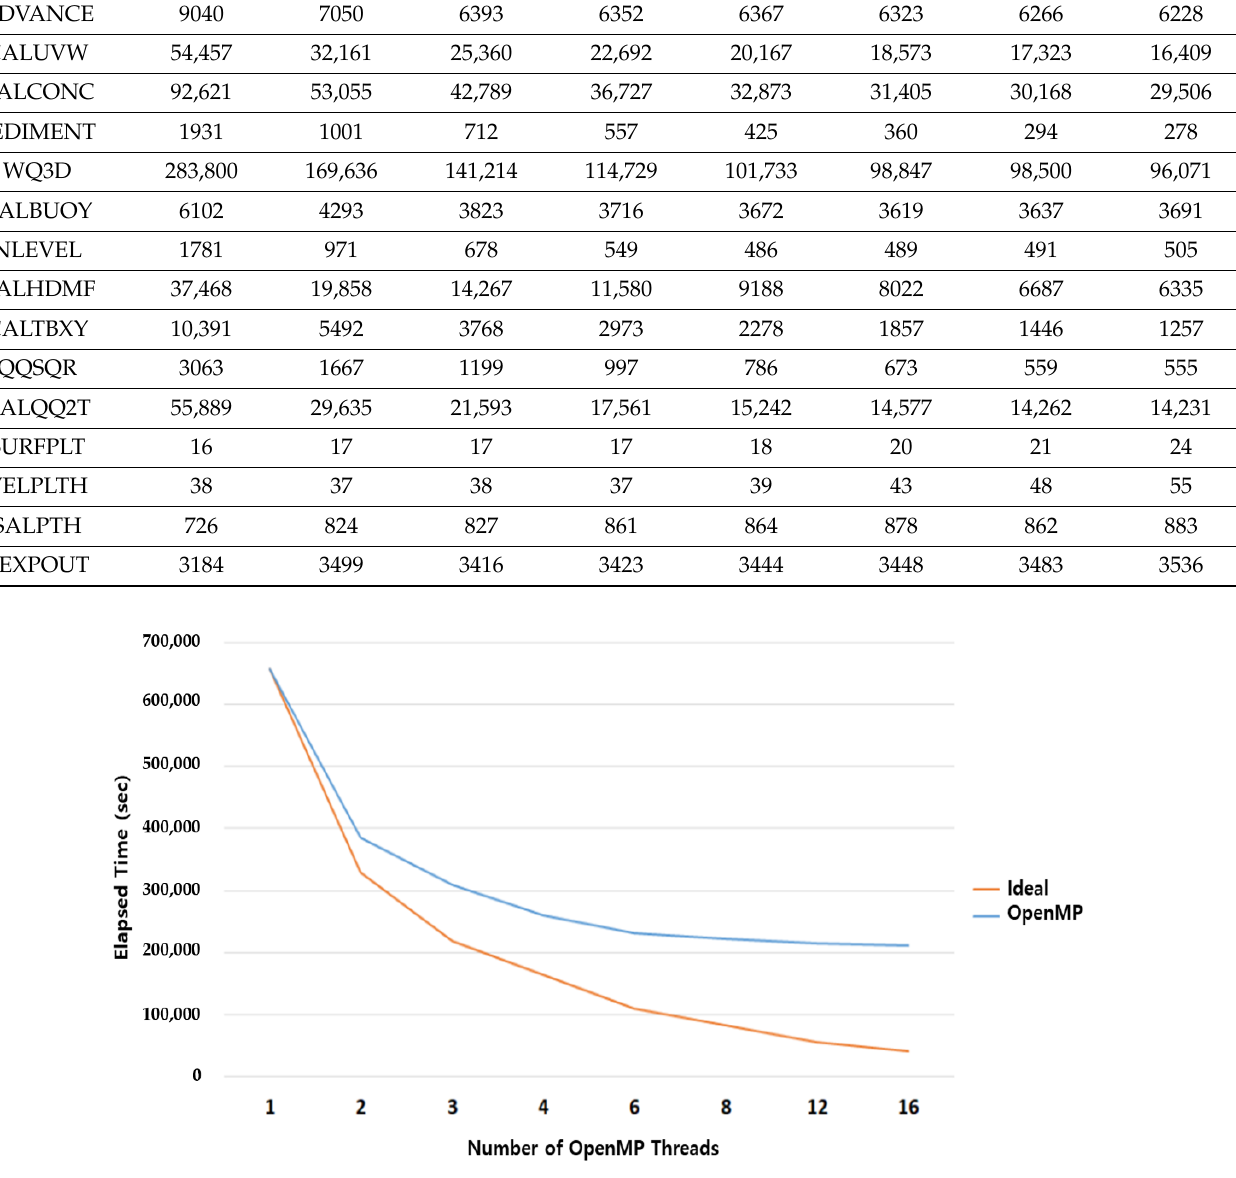
Figure C1. Execution time as a function of the number of OpenMP threads (detailed grid #2 of Nakdong River). (2) MPI Parallel Performance